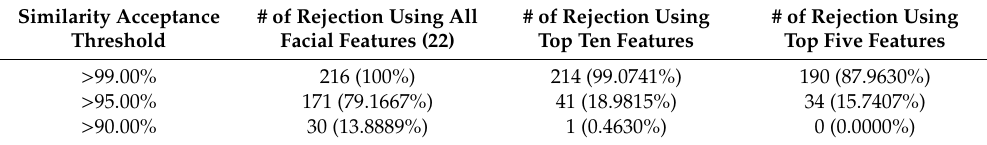
Table 14. False rejection rate (FRR) at di ff erent acceptance